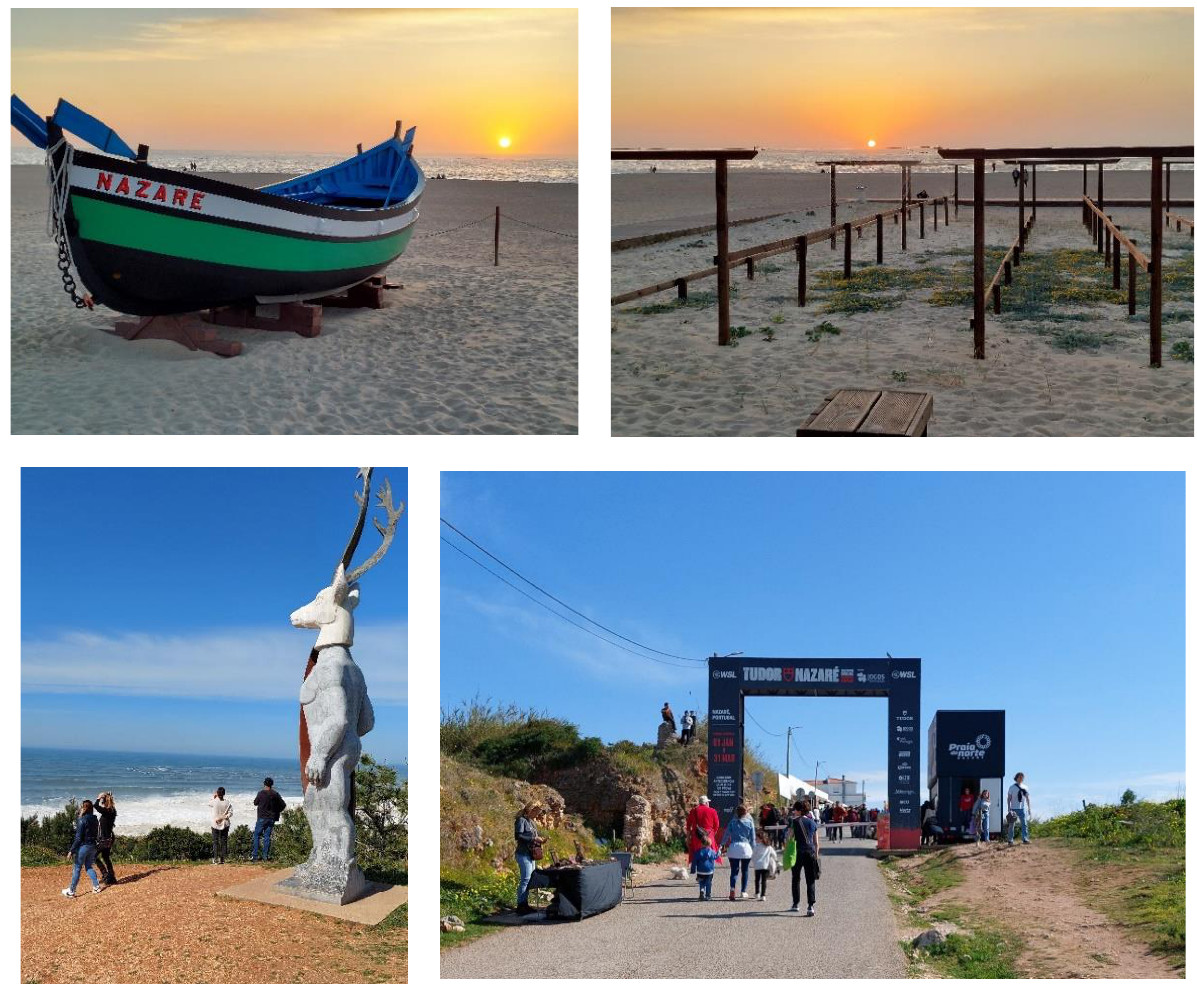
Figure 4. Author ’ s photos taken on the ethnographic trip showing some examples of cultural eco- Figure 4. Author’s photos taken on the ethnographic trip showing some examples of cultural system services of heritage and inspiration for art. ecosystem services of heritage and inspiration for